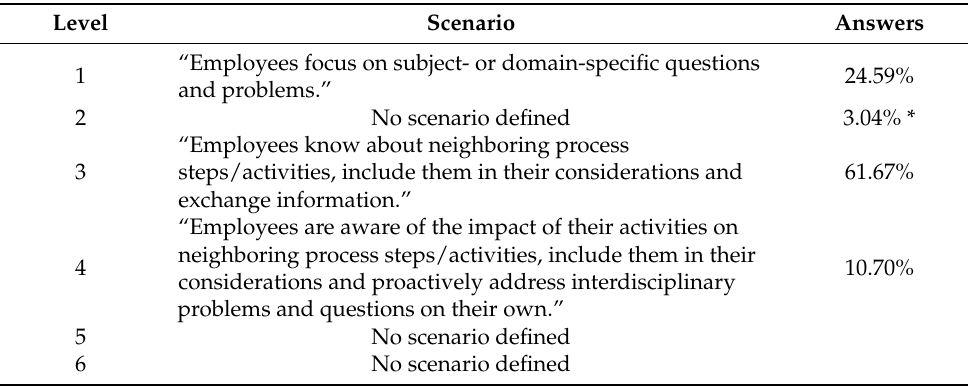
Table 10. Results for the capability “Interdisciplinary skills of